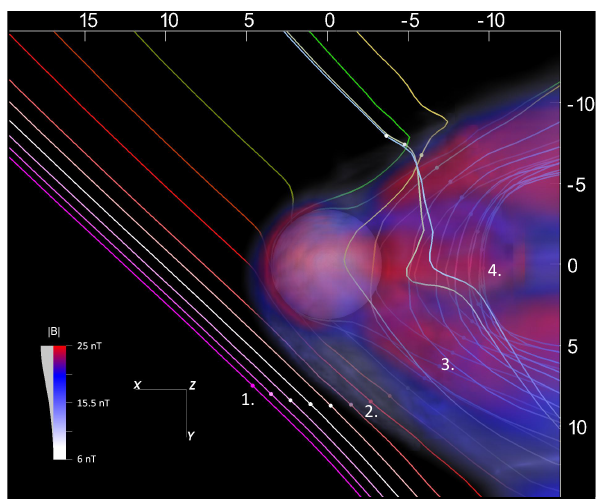
Fig. 4. The simulated magnetic field around Mars and several mag- netic field lines which are connected to the orbit of Phobos-2. The “cloud” in the figure is a volumetric plot of the magnitude of the magnetic field. The magnetic field lines are coloured in order to help the eye to distinguish different lines from each other. The view point is on the + z-axis. Note that the draped magnetic field lines are three-dimensional in the simulation and the figure only shows their projection on the xy-plane. The unit on the coordinate axis is 1000km. See the text for a description of how the morphology of the magnetic field changes when Phobos-2 moves from the solar wind (point 1) deep into the magnetotail (point